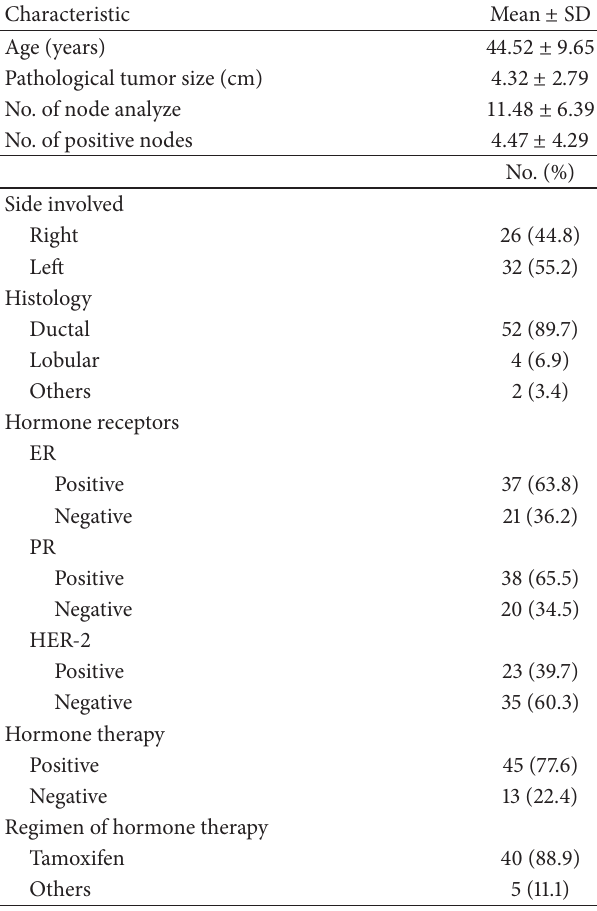
Table 1: Clinical characteristic of